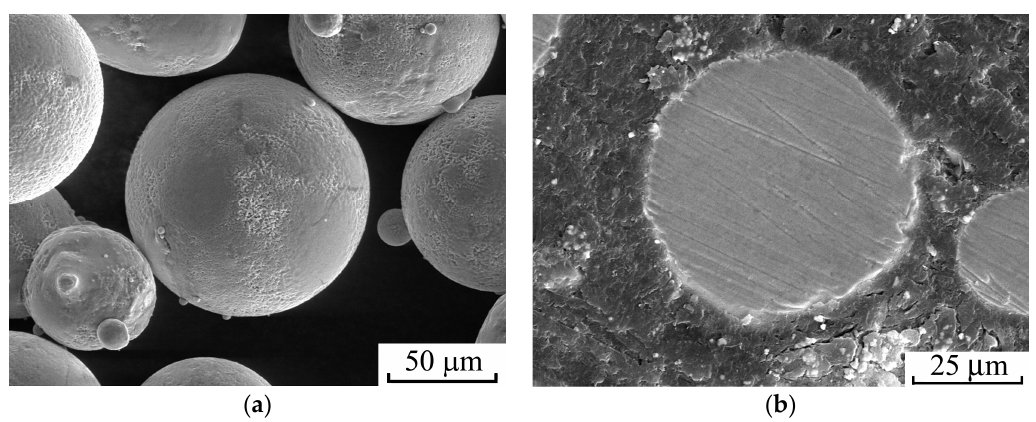
Figure 1. Morphology of Ni60 powders: ( a ) global; ( b ) cross-sectional.